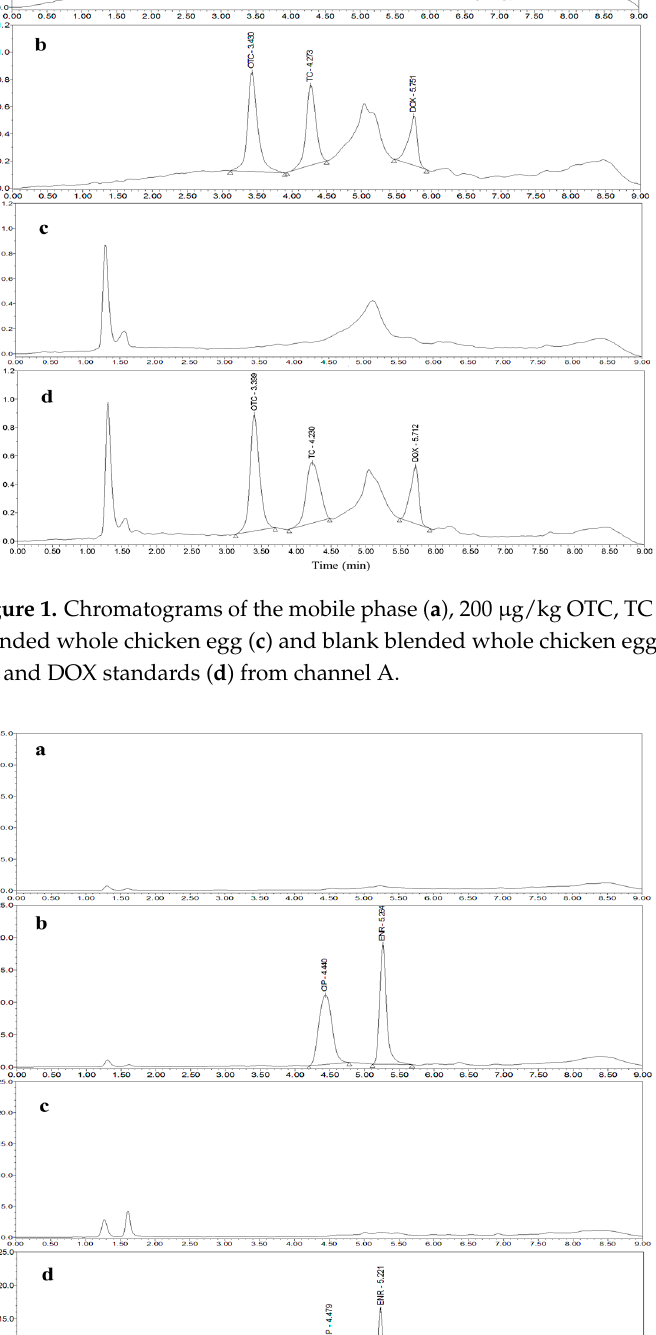
Figure 3. Chromatograms of the mobile phase ( a ), 200 μ g/kg OTC, TC and DOX standards ( b ), blank chicken albumen ( c ) and blank chicken albumen spiked with 200 μ g/kg OTC, TC and DOX stand ‐ ards ( d ) from channel A.